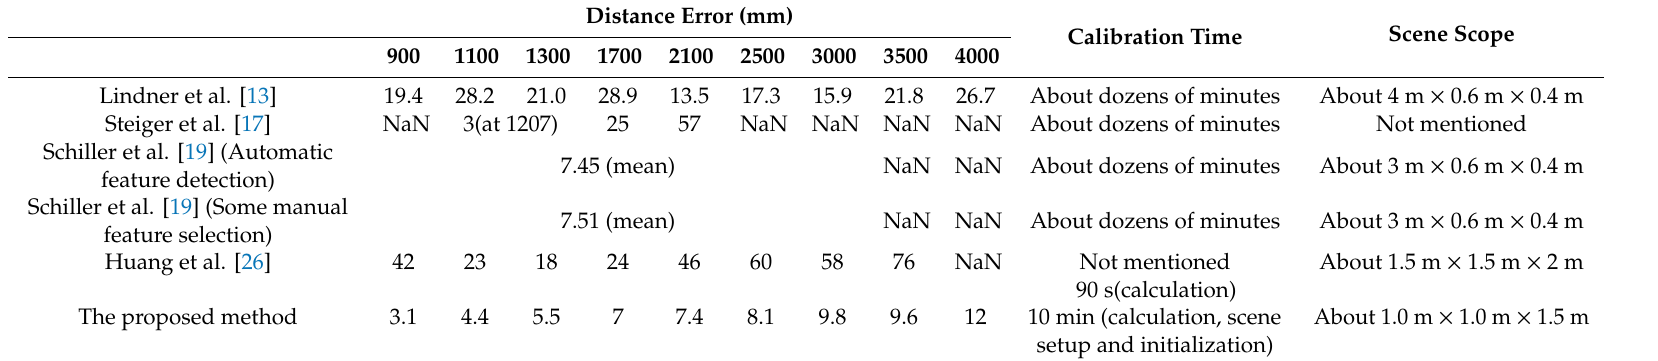
Table 5. Detailed performance compared with traditional